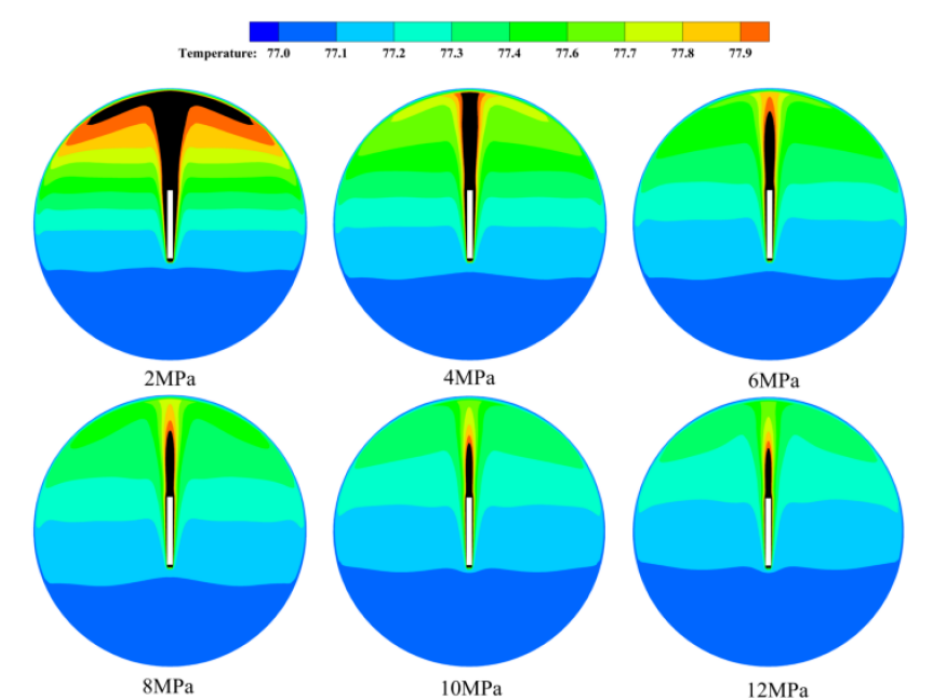
Figure 7. Temperature distribution of the supercritical helium under different conditions (heating power: 10 W, temperature range: 77–78